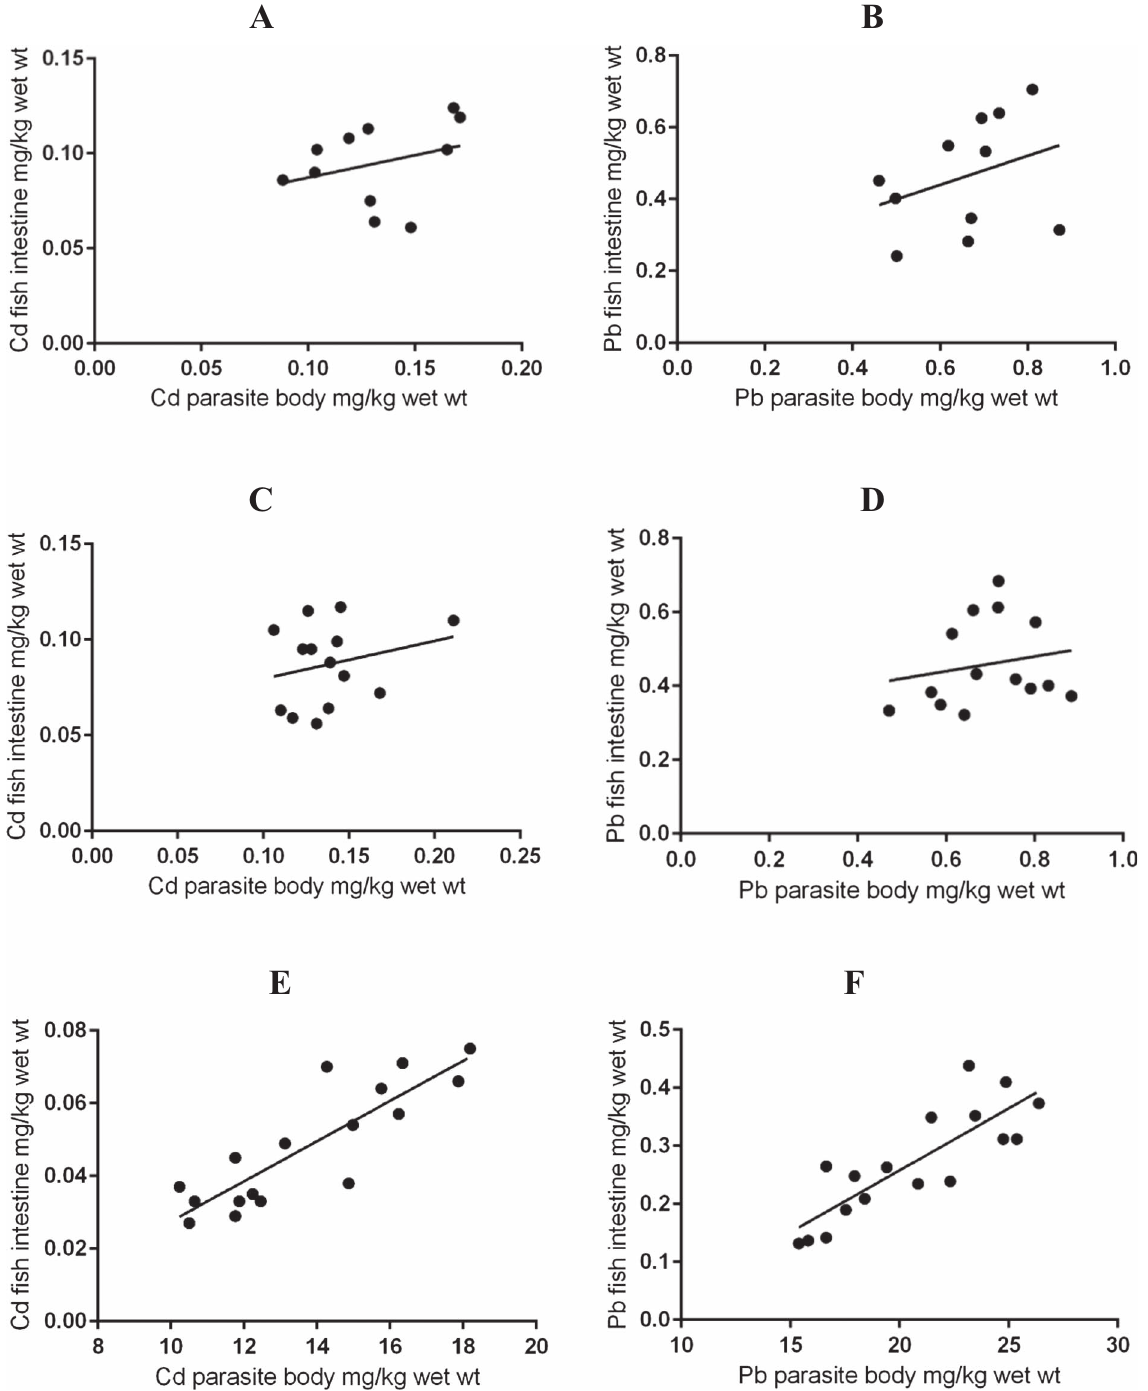
Figure 1. The relationships between metal concentrations in fi sh intestines and their concentrations in intestinal helminth parasites: (A) Cd concentrations in fi sh intestines vs. concentrations in G. volubilis ; (B) Pb concentrations in fi sh intestines vs. concentrations in G. volubilis ; (C) Cd concentrations in fi sh intestines vs. concentrations in P. elatensis ; (D) Pb concentrations in fi sh intestines vs. concentrations in P. elatensis ; (E) Cd concentrations in fi sh intestines vs. concentrations in S. rubrimaris ; and (F) Pb concentrations in fi sh intestines vs. concentrations in S. fi sh intestines increased, their concentrations in the parasite p < 0.0001; R 2 = 0.7742, slope = (cid:2) 0.001469, p < 0.0001, body increased. There were strong negative relationships be- respectively) (Fig. 2E and F), i.e. as the infrapopulation size tween Cd or Pb concentrations in fi sh intestines and S. rubri- of S. rubrimaris in the intestines of S. rivulatus increases, the maris infrapopulation size ( R 2 = 0.8026, slope = (cid:2) 0.00026, concentrations of both Cd and Pb in fi sh intestines signi fi cantly